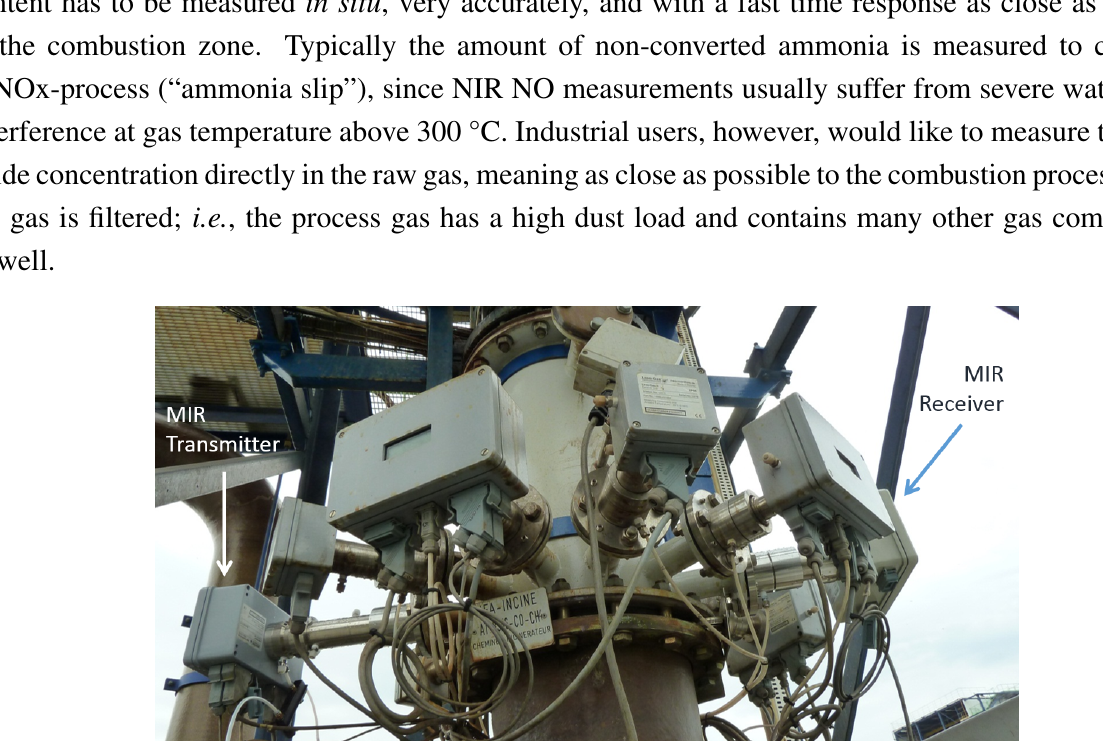
Figure 10. Installation of the mid-infrared NO sensor on a stack of an Arkema Forane-plant near Lyon (France).